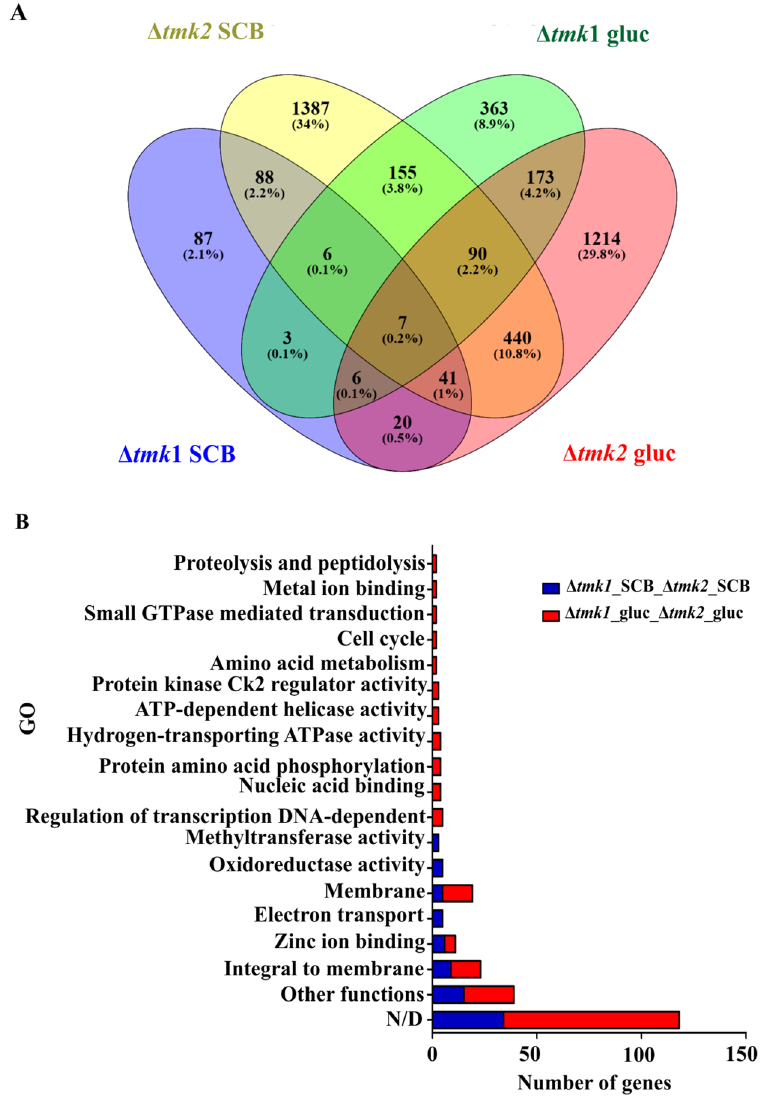
Figure 3. Expression pattern of genes commonly expressed between the Δ tmk1 and Δ tmk2 representing the number of differentially expressed genes in the presence of glucose and sugarcane bagasse. ( A ) Comparative Venn diagram of commonly expressed genes between the Δ tmk1 and Δ tmk2 strains in the presence of glucose and sugarcane bagasse. Venn diagram clustering was designed using Venny 2.1 tools. ( B ) Gene Ontology (GO) enrichment analysis of commonly expressed genes between the Δ tmk1 and Δ tmk2 strains in the presence of glucose and sugarcane bagasse. The enriched GO terms according to molecular, cellular component, and biological process in T. reesei . Significantly enriched categories (P ≤ 0.05) are shown. The threshold for calling differentially expressed genes was P ≤